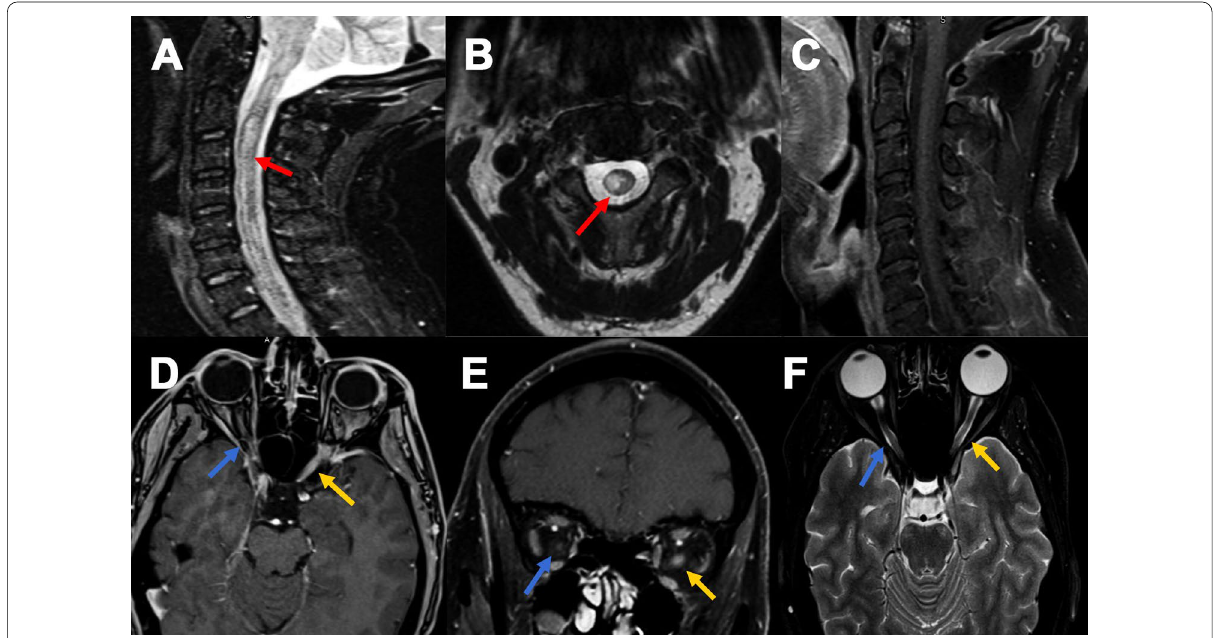
Fig. 1 MRI sagittal STIR images ( A ) of the cervical spine reveal ill-defined long segment hyperintensity with prominent cord expansion C2–C4 (red arrow); B shows axial cut with cord signal alteration at C3 (red arrow), and C post-contrast sagittal image showed no abnormal enhancement. MRI orbit Axial T1-weighted fat suppression post-contrast ( D ) and coronal images ( E ) reveals abnormal enhancement of left optic nerve pre-chiasmatic (intracanicular); (yellow arrow) with corresponding hyperintense on axial T2 weighted images ( F ) (yellow arrow) with no abnormality of the right optic nerve (blue